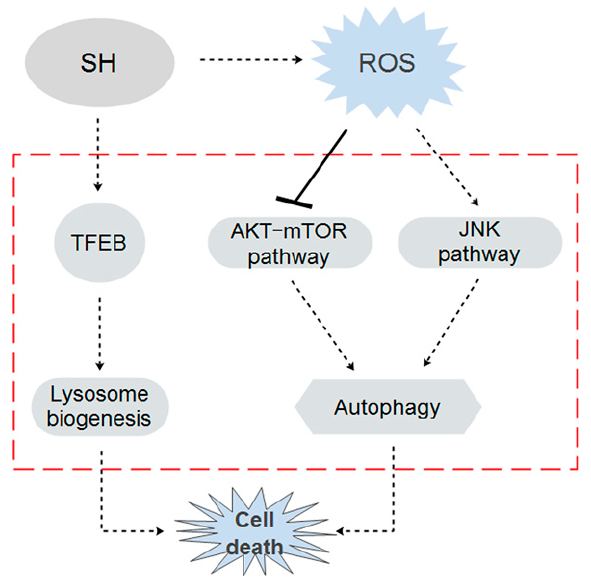
Figure 8. Proposed model delineating the mechanisms of SH action in the human glioblastoma